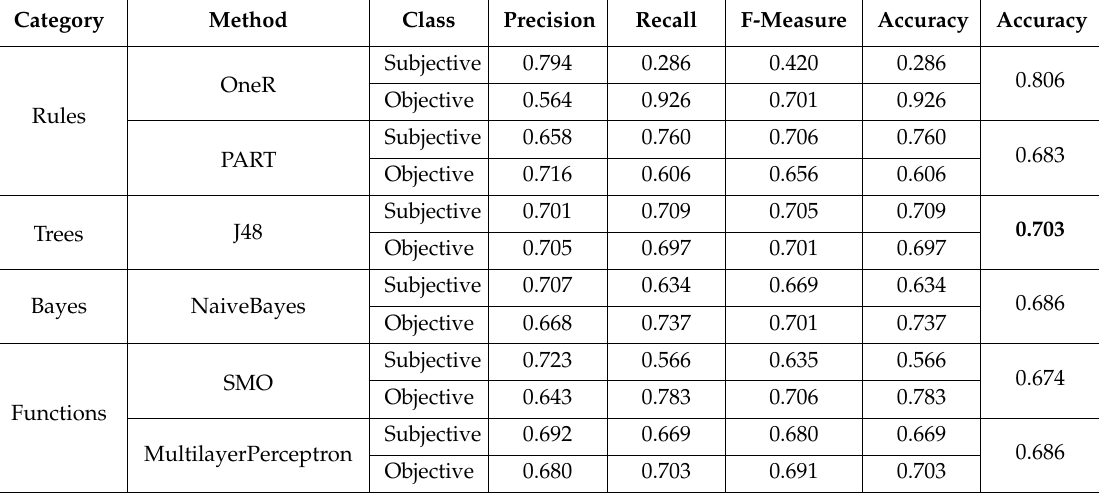
Table 8. Results for the discourse